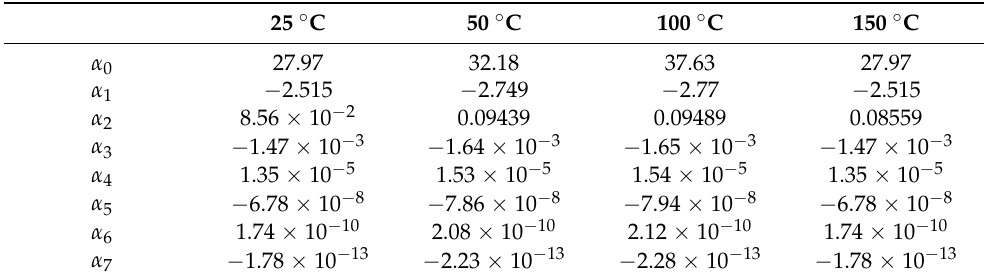
Table 4. Polynomial simulation factors for the shift curve α (T) at different reference temperatures for